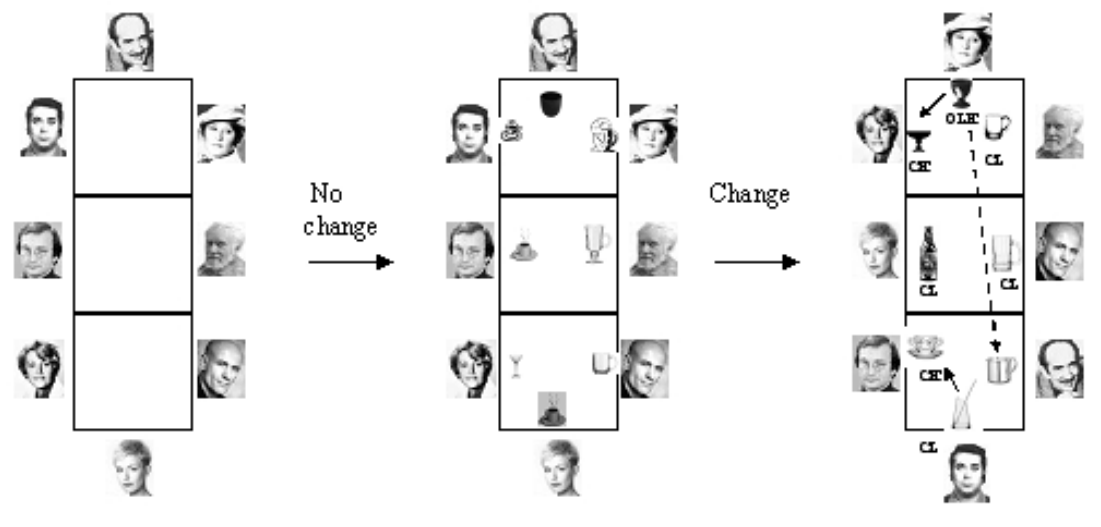
Fig. 1. Diagram (an example) of the experiment performed in the Cafes of Buenos Aires. First the customers order, the subject comes back and delivers it without errors, in the second round the customers change seats and the errors